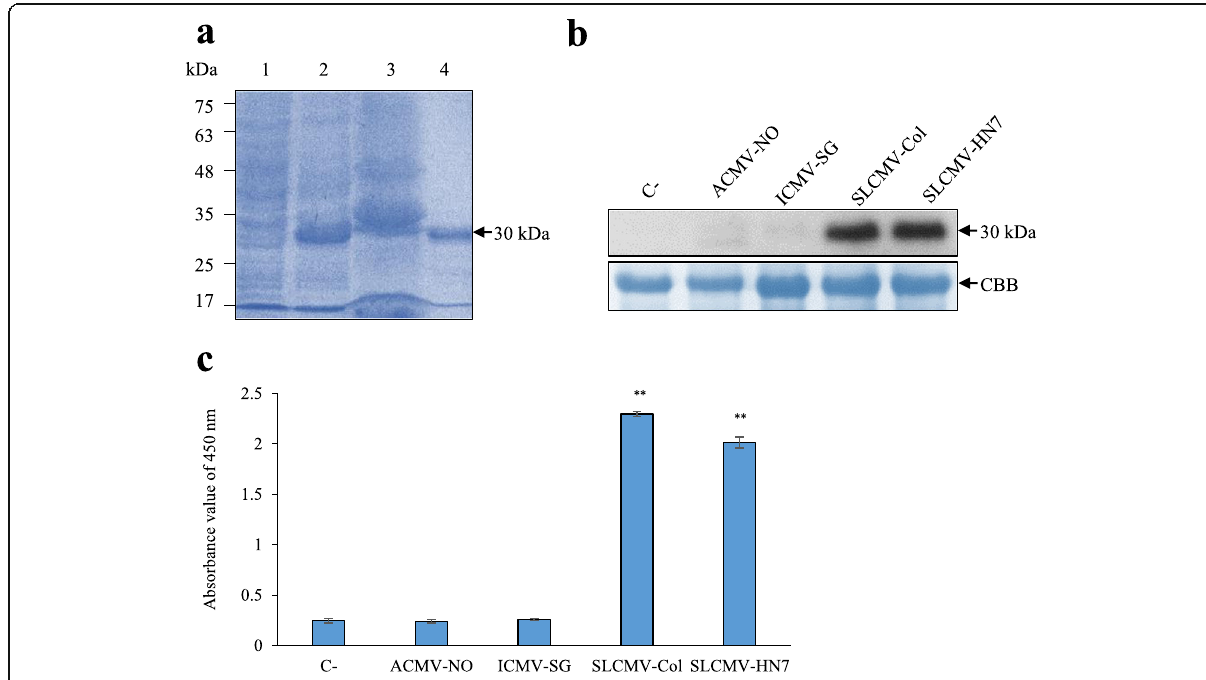
Fig. 3 Protein purification of SLCMV capsid protein (CP) and identification of specificity of CP polyclonal antibody. a Prokaryotic expression and purification of SLCMV-HN7 His-CP recombinant proteins in E. coli . 1: Before induction of CP; 2: supernatant of induced CP with sonication; 3: precipitation of induced CP with sonication; 4: elution of fusion protein. The specificity of CP polyclonal antibody was evaluated by Western blot ( b ) and ELISA ( c ). C – , healthy cassava. Values are